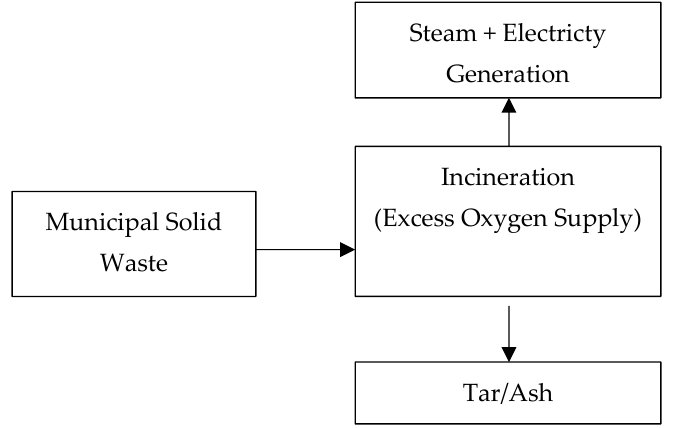
Figure 2. Incineration process system.